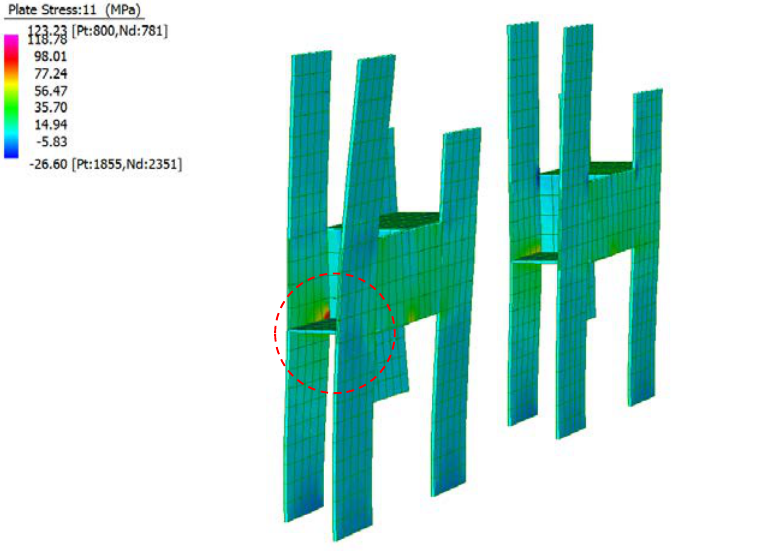
Fig. 5: Plate Stress: Left structure with zero gap elements / right structure with monolithic linked glass panels The first FEM Model shows singular peak stress of 123 MPA (Fig. 6a) while the monolithic structure reaches only 78 MPa (Fig. 6b) at the same location. Also visible in Fig. 6b is the enlarged opening of the glass connection as well as the warping in the area without a PVB bonding.